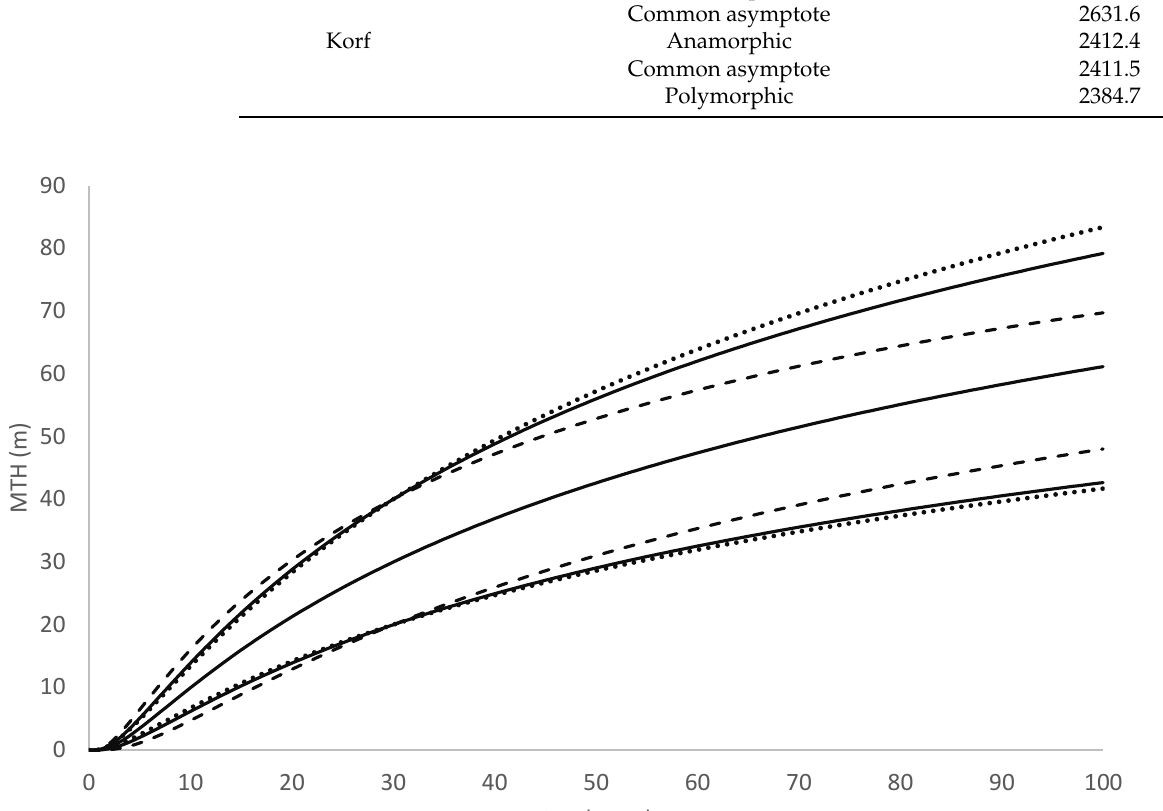
Figure 3. Comparison of the polymorphic form of the Korf model (solid lines) with the anamorphic (dotted lines) and common asymptote (dashed lines) forms, fitted to the redwood MTH data. The central solid line is for SI = 30 m, the three lower lines are for SI = 20 m and the upper three lines are for SI = 40 m.